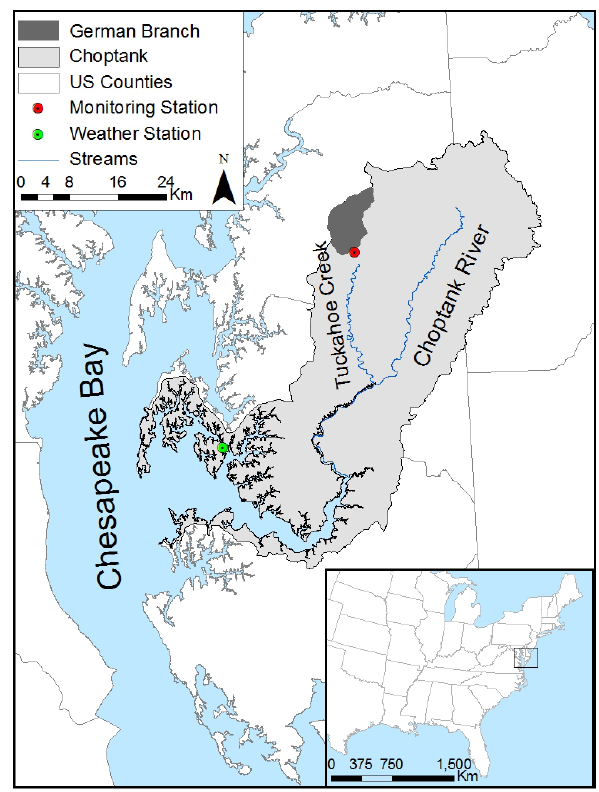
Figure 1. Geographical location of the study area (German Branch watershed, with the size of 50km 2 ).